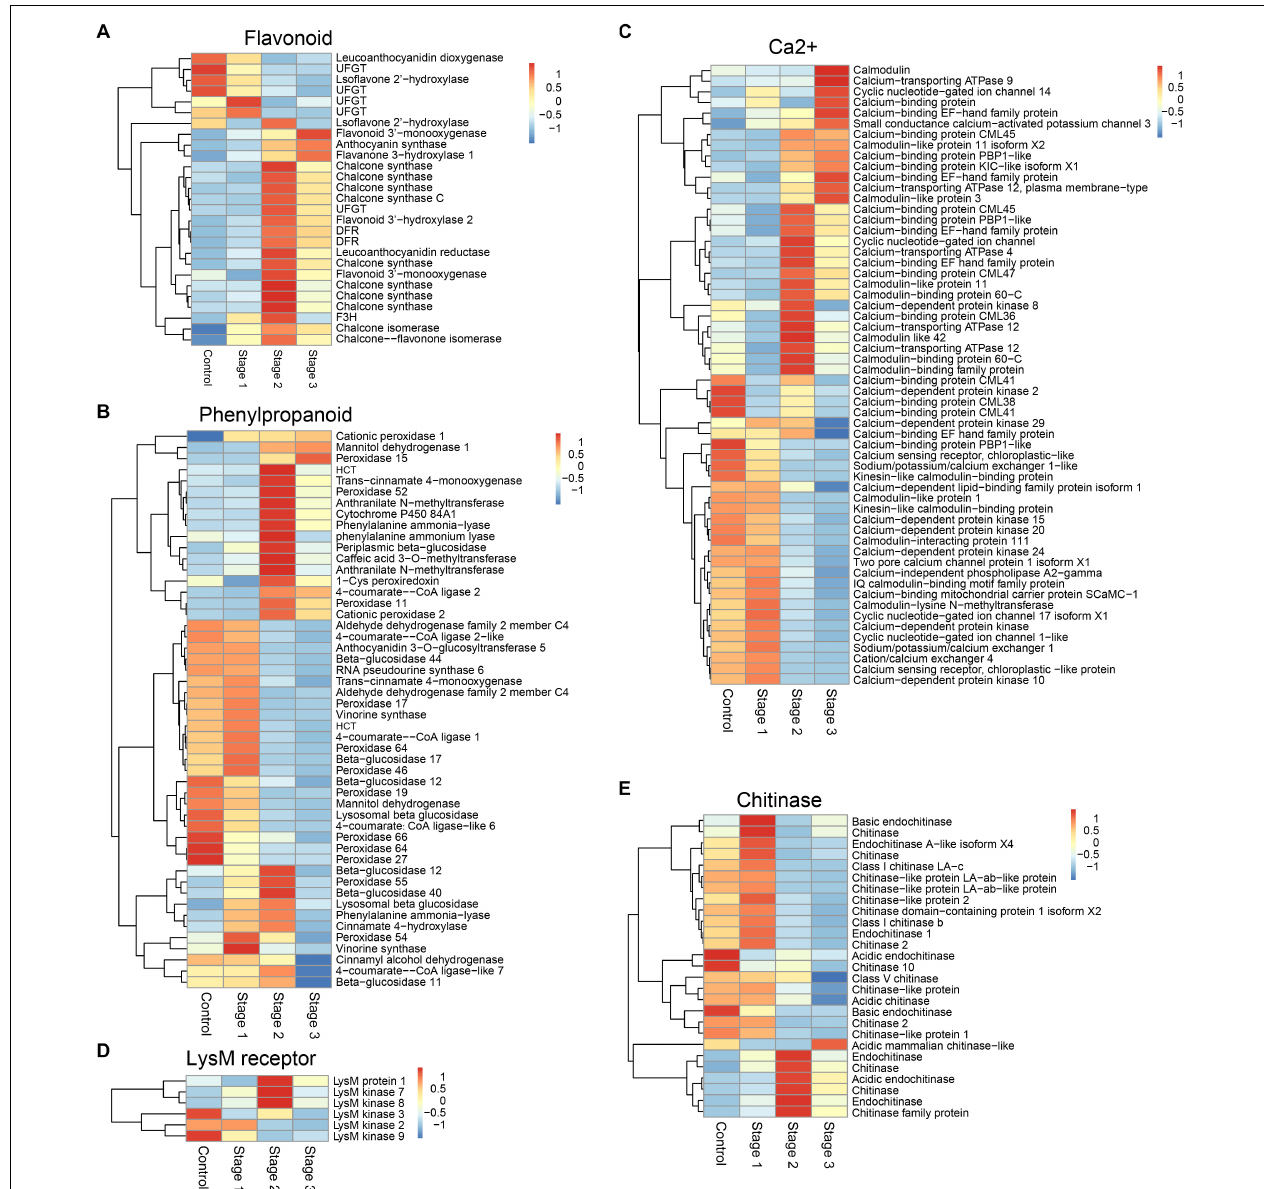
FIGURE 1 | DEGs associated with different defense-associated biosynthetic pathways or gene families. (A–B) DEGs in flavonoid biosynthesis and phenylpropanoid biosynthesis pathways. (C) DEGs related to calcium signal transduction. (D) DEGs encoding lysM motif receptor. (E) DEGs encoding chitinase. DFR, bifunctional dihydroflavonol 4-reductase/flavanone 4-reductase; UFGT, UDP-glucose flavonoid 3-O-glucosyltransferase; F3H, flavanone 3-hydroxylase; HCT, hydroxycinnamoyl-Coenzyme A shikimate/quinate